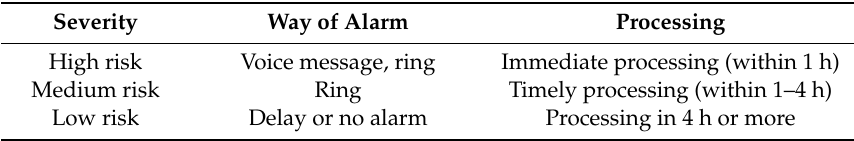
Table 8. The processing method for alarm messages of every risk